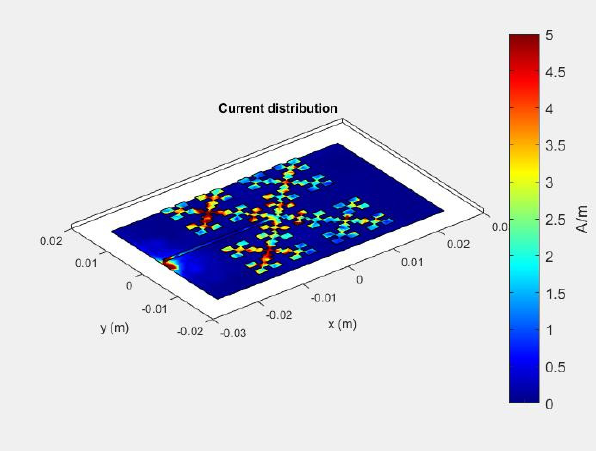
Figure 8. Fractal island normal antenna at 191 GHz.